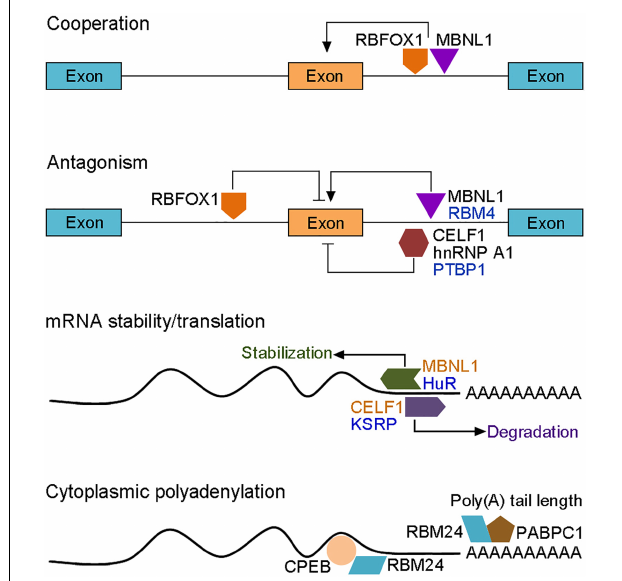
FIGURE 3 | Functional interactions between RBPs in the post-transcriptional regulation of myogenic gene expression. RBPs (colored forms) act either cooperatively or antagonistically to control muscle-specific alternative splicing, cytoplasmic polyadenylation, mRNA stability and translation (arrows represent positive regulation; bars represent negative regulation; RBPs that display antagonistic activity in alternative splicing and mRNA stability are shown by identical colors). The activity of a particular RBP is also dependent on its interaction with the pre-mRNA. RBFOX1 inhibits or promotes inclusion of the adjacent exon upon upstream or downstream binding, respectively. RBPs-mediated mRNA degradation or translation either positively or negatively regulates myogenic differentiation, depending on the targets. RBM24-mediated cytoplasmic polyadenylation of muscle-specific target mRNAs also await further